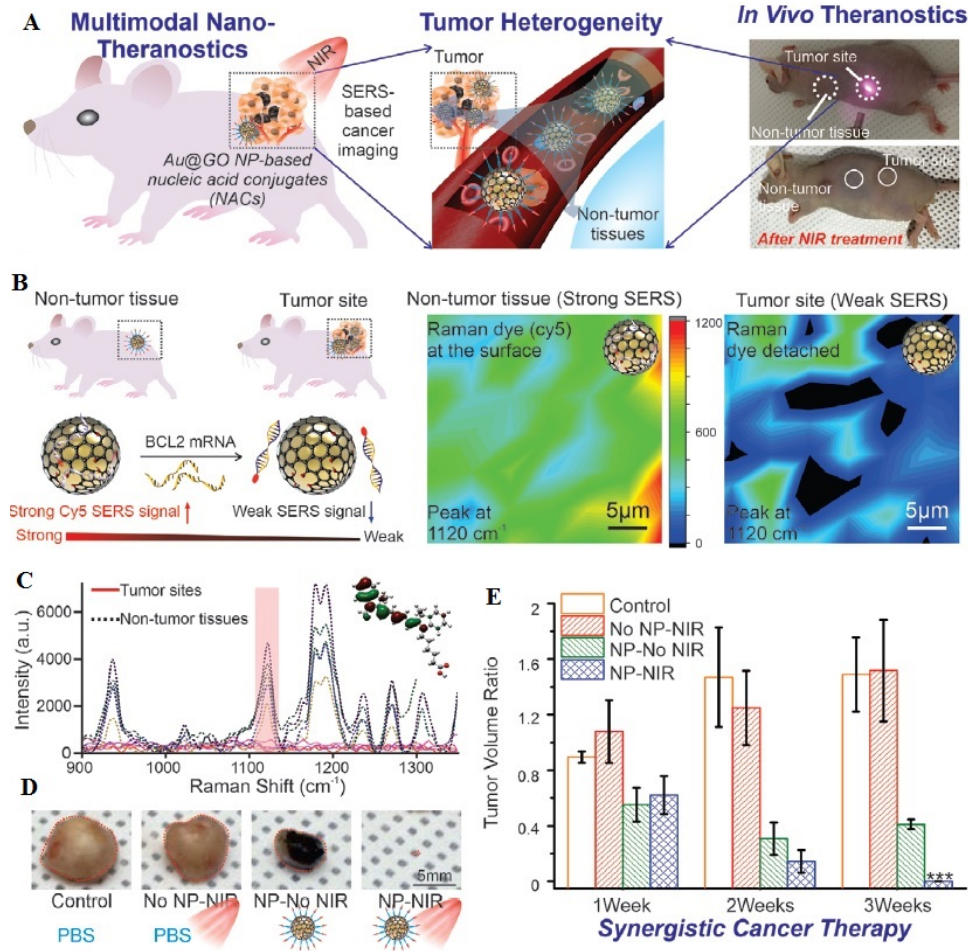
Figure 10. In vivo Raman (SERS) imaging and multimodal therapy of cancer. ( A ) Au@GO NP-NACs injected mice, tumor heterogeneity and PT. ( B ) Schematic diagram for non-tumor and tumor tissue and corresponding SERS mappings. ( C ) Raman shifts and SERS intensities at tumor sites and non-tumor tissues. ( D ) Extracted tumor from mice after 3 days of PT, the images are for control, without NP and NIR laser, with NP and without NIR laser, with NP and with NIR laser treated tumor and its volume. The NP-NIR treated tumor has shown a complete shrinkage of tumor. ( E ) The tumor volume ratio with synergistic cancer therapies of control, no NP-NIR, NP-No NIR, and NP-NIR. After 3 weeks of the therapy, the NP-NIR gave a remarkable therapy result of close to zero tumor volume ratio. Reprinted/adapted with permission from Ref. [139]. Copy right 2020, copyright Wiley-VCH.